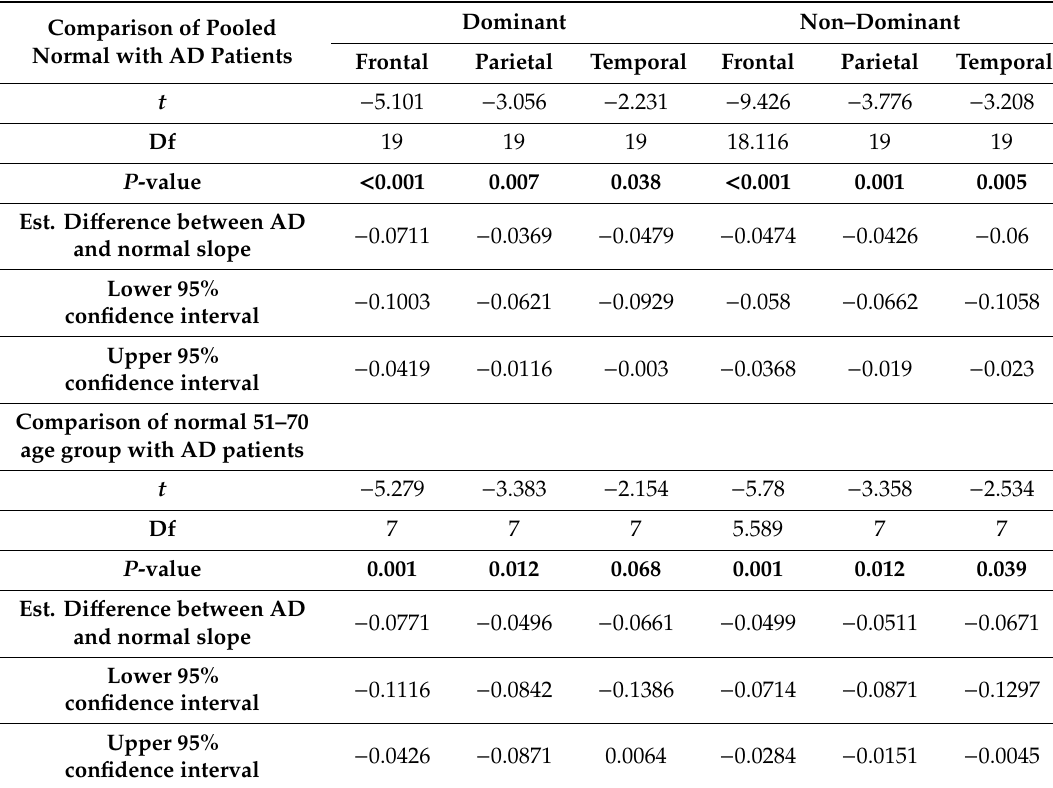
Table A1. Statistical analysis comparing AD subjects with normal in the PASL MRI study. Comparative statistics of normal and AD patients; dominant and non-dominant